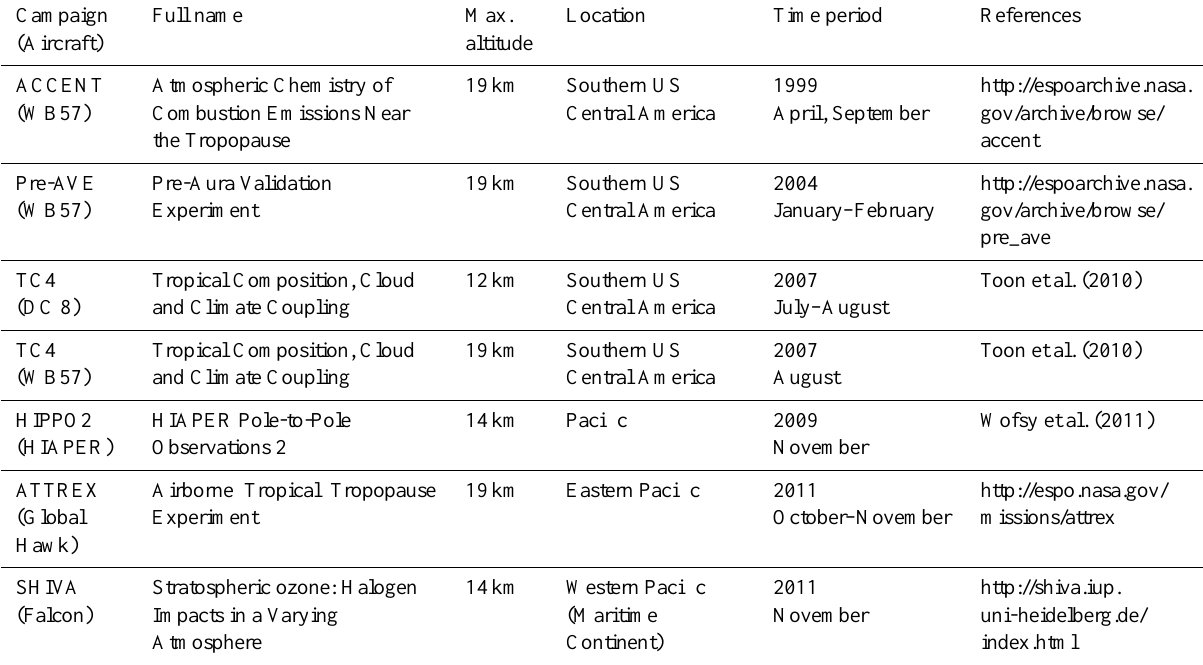
Table 3. Aircraft campaigns with CH 3 I measurements used in the